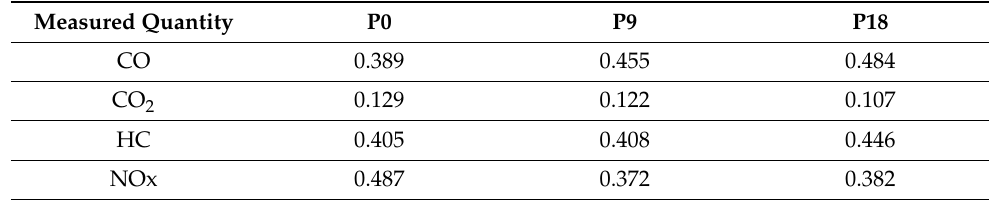
Table 3. Co-efficient of variance for measured